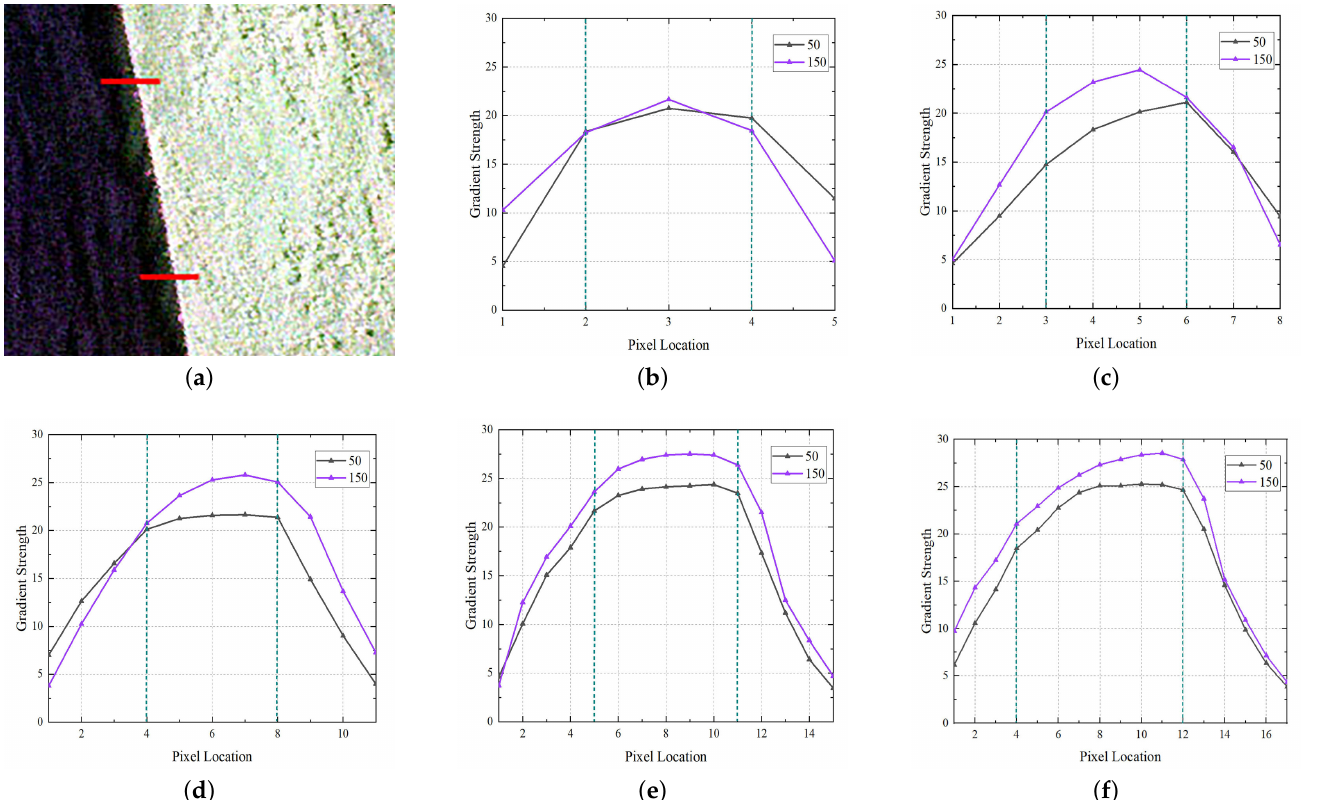
Figure 14. Analytical results for µ with different ρ . ( a ) PauliRGB Image (red lines represent the pixel locations, which are the 50th and 150th rows, respectively). ( b ) ρ = 1. ( c ) ρ = 2. ( d ) ρ = 3. ( e ) ρ = 4. ( f ) ρ =